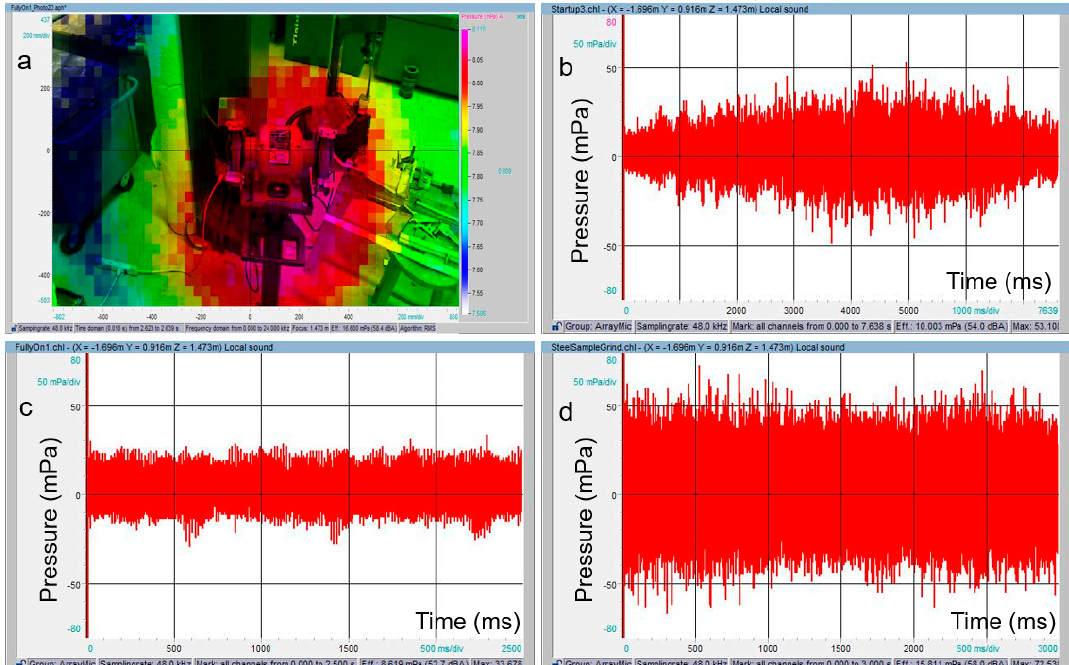
Figure 3. Acoustic emission for bench grinder: ( a ) 2D image superimposed with noise mapping intensity; ( b ) noise emission during startup; ( c ) noise emission during idle speed; and, ( d ) noise emission during load.